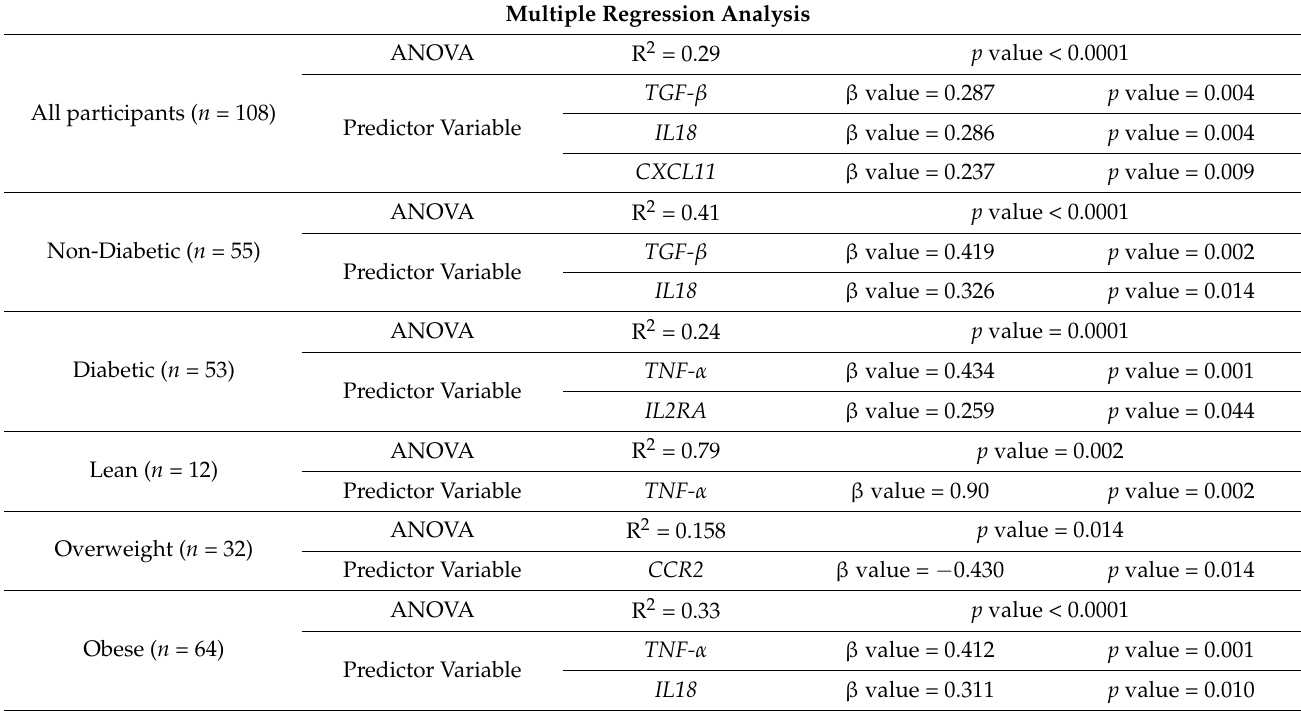
Table 5. Multiple linear regression